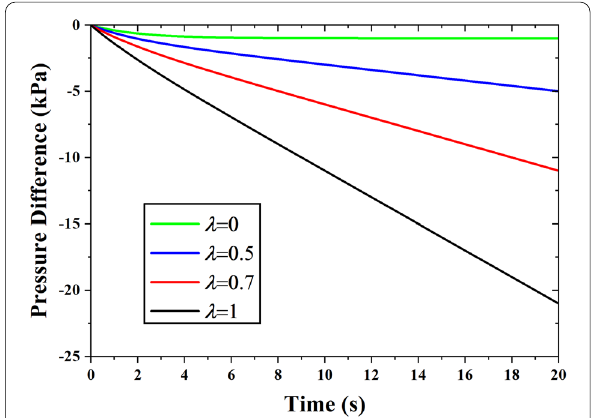
Figure 4 Relationship of α and pressure difference without leakage